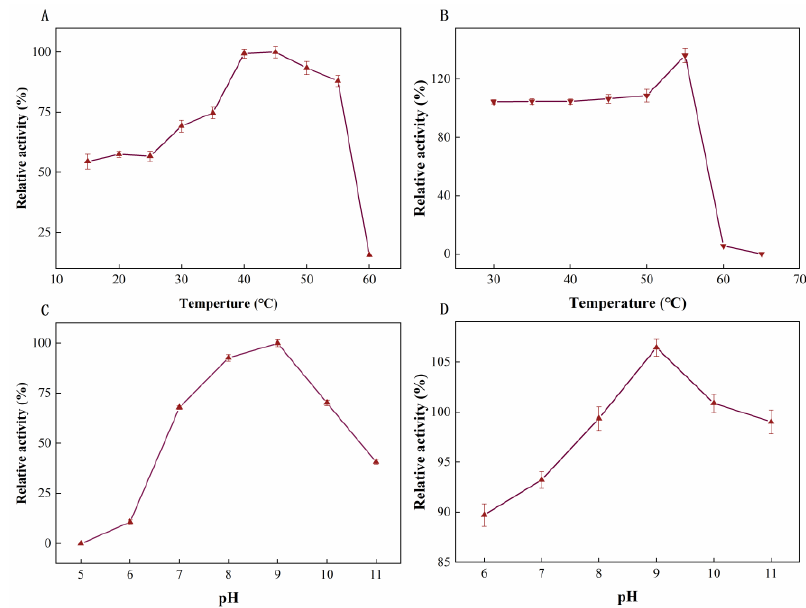
Figure 4. Effect of pH and temperature on LUCA−DmpA . ( A ) The optimum reaction temperature of LUCA−DmpA was 45 °C. ( B ) After incubation at 30 – 55 °C for 30 min, LUCA−DmpA ancient enzyme activity was stable; no remaining activity was detected when the temperature reached to 65 °C. ( C ) The optimum reaction pH of LUCA−DmpA was 9.0. ( D ) After LUCA−DmpA was incu- bated at different pHs (pH = 6 – 11) for 12 h, it showed higher relative activity.